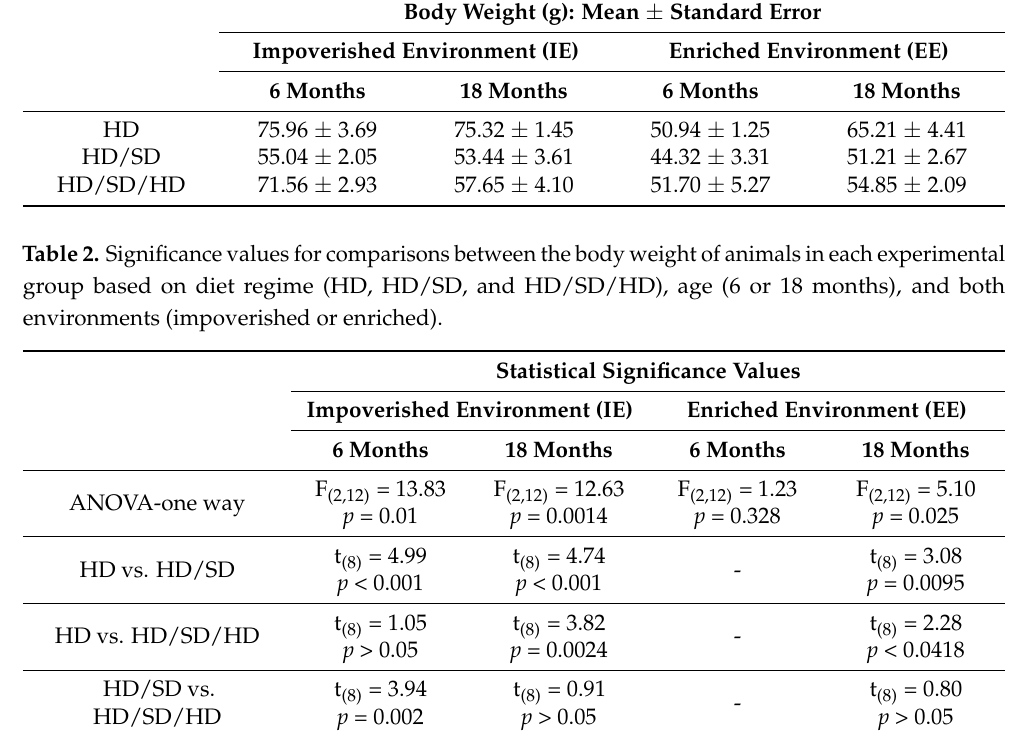
Table 1. The mean and standard error of the body weight (g) of animals for each experimental group based on diet regimen (HD, HD/SD, and HD/SD/HD), age (6 or 18 months), and both environments (impoverished or enriched).